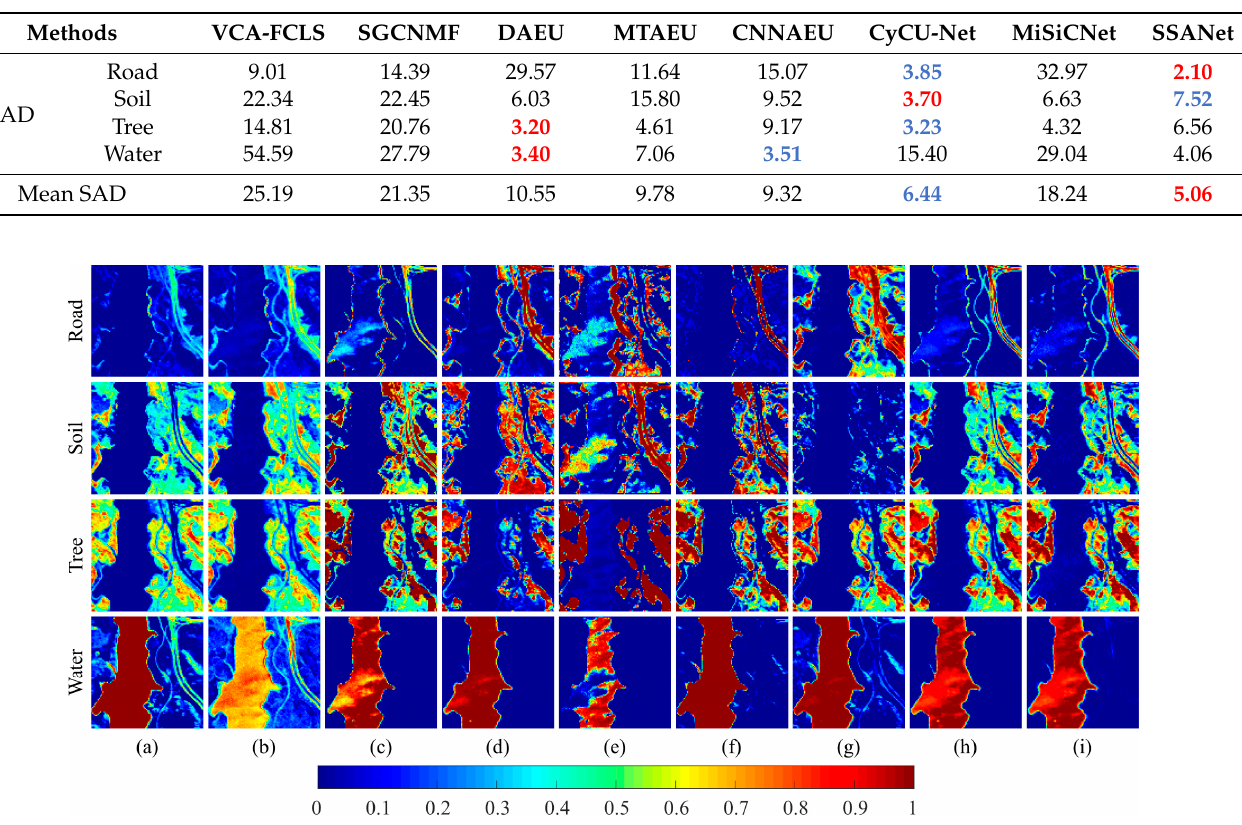
Figure 13. Visualization results of the abundances of Jasper Ridge data. ( a ) VCA-FCLS. ( b ) SGCNMF. ( c ) DAEU. ( d ) MTAEU. ( e ) CNNAEU. ( f ) CyCU-Net. ( g ) MiSiCNet. ( h ) SSANet. ( i ) GT.